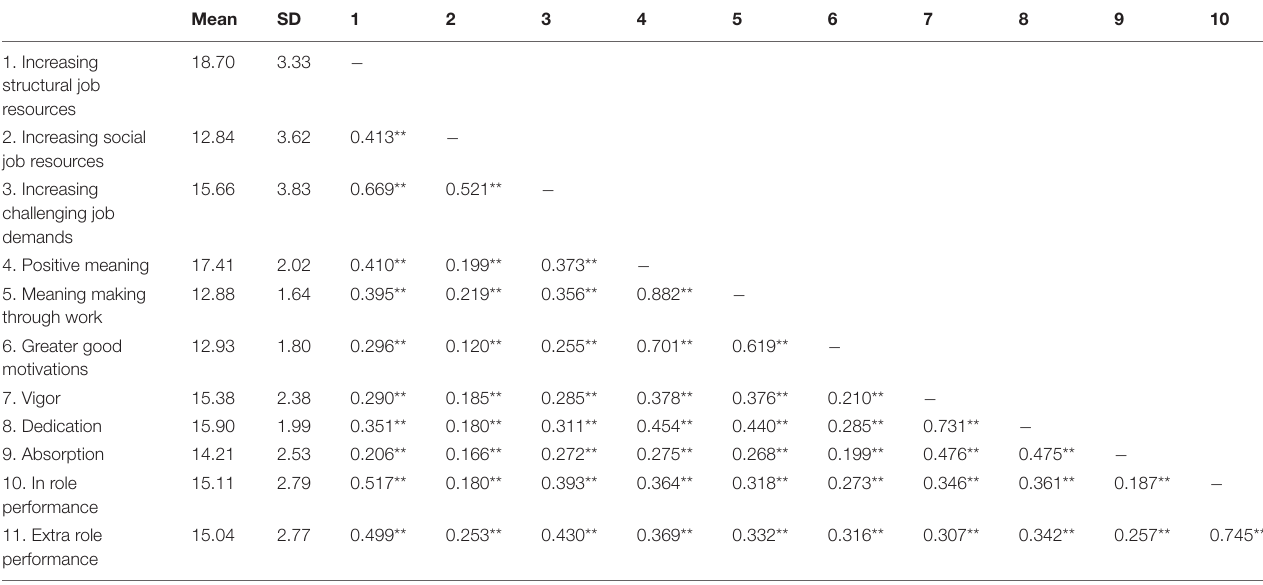
TABLE 1 | Descriptive statistics and inter-correlations of the study